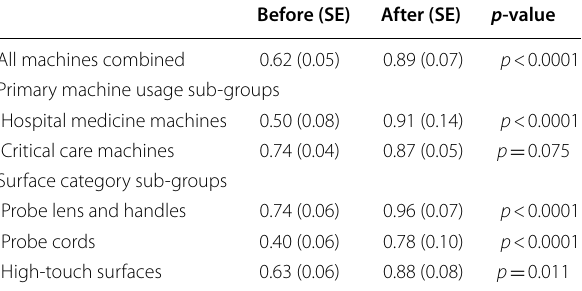
Table 1 Model-adjusted ultrasound machine cleaning